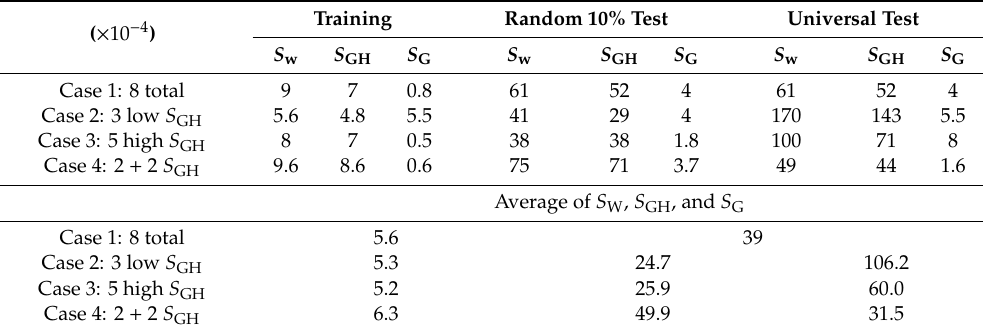
Table 4. Mean square error (MSE) of training and test sets for Cases